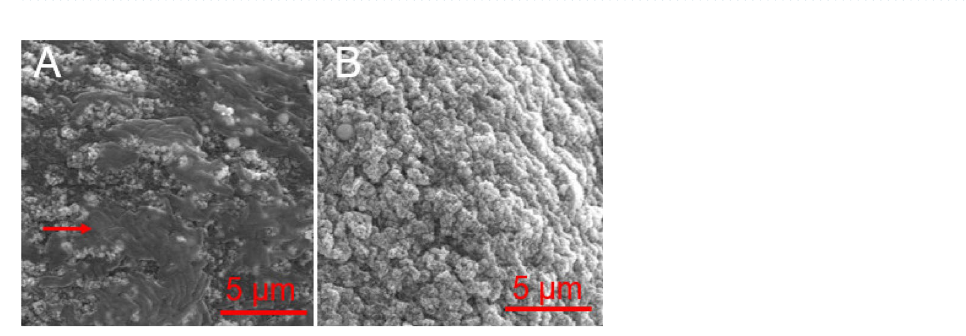
Figure 2. FL microscope image of stained P. aeruginosa . ( A ) bright field, ( B ) green FL channel, ( C ) red FL channel.